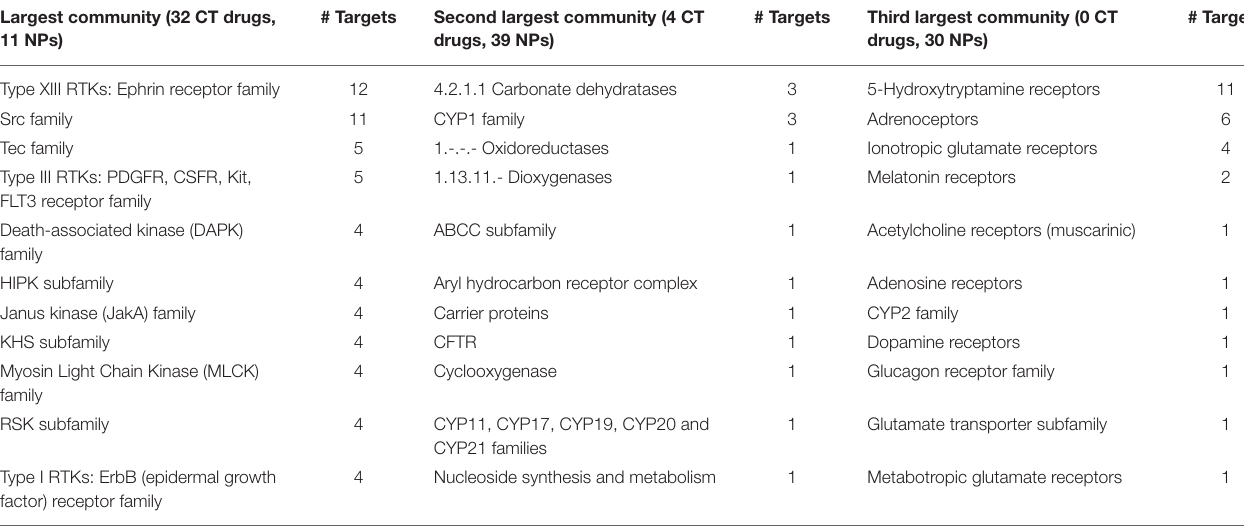
TABLE 3 | Natural products (NP) and approved cancer drugs (CT) interact with disjoint and shared target sets. Largest community (32 CT drugs, 11 NPs)